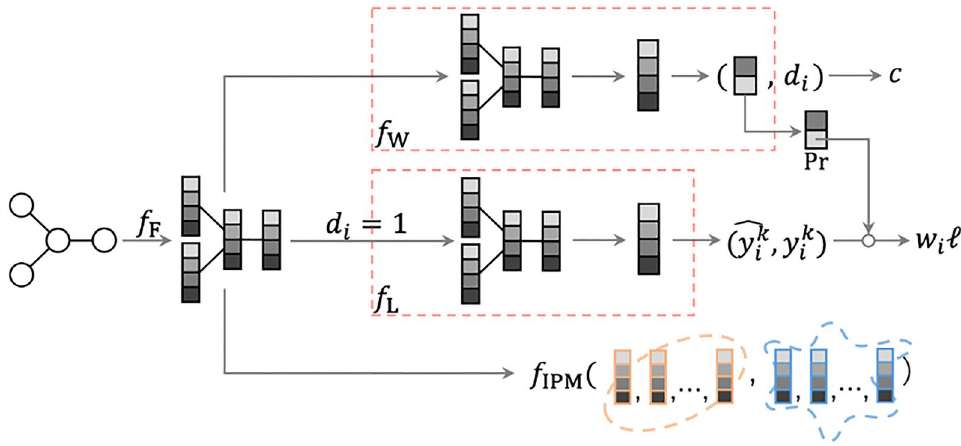
Figure 7. Architecture of the end-to-end CFR